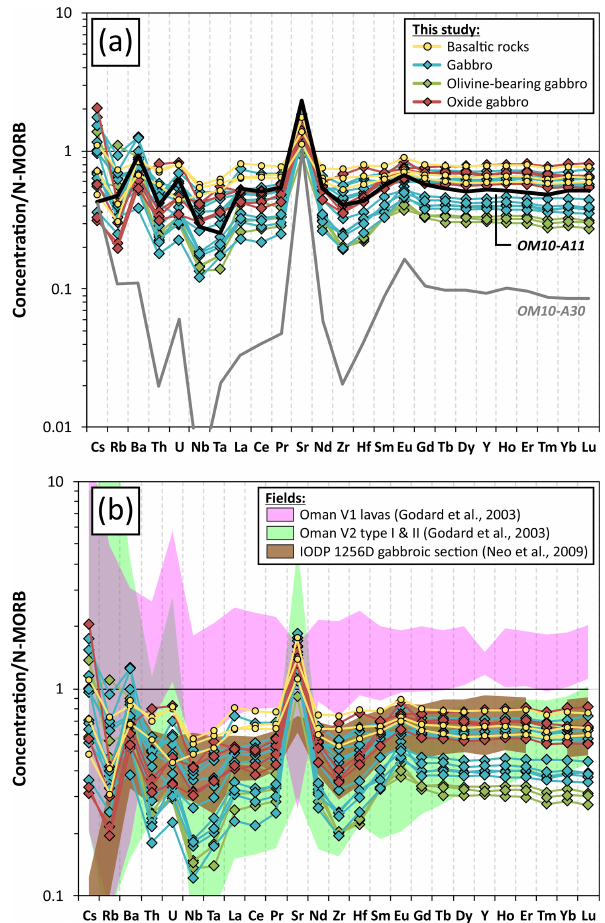
Figure 13. (a) Multi-element diagram (trace element concentration normalized to N-MORB of Gale et al., 2013) for bulk rock compo- sitions from gabbros and basalts from the GT3A drill core. As com- parison, rocks from the Oman Wadi Gideah reference transect are included (Garbe-Schönberg et al., 2022). OM10-A11, a primitive basalt from the sheeted dike complex (black line), and OM10-A30, a primitive olivine gabbro of the lower gabbro sequence (gray line). (b) Same diagram with a narrower scale. Compositional fields for Oman V1 and V2 lavas (Godard et al., 2003) are included, as well as for gabbros from the IODP core drilled at Site 1256 (Neo et al., 2009).